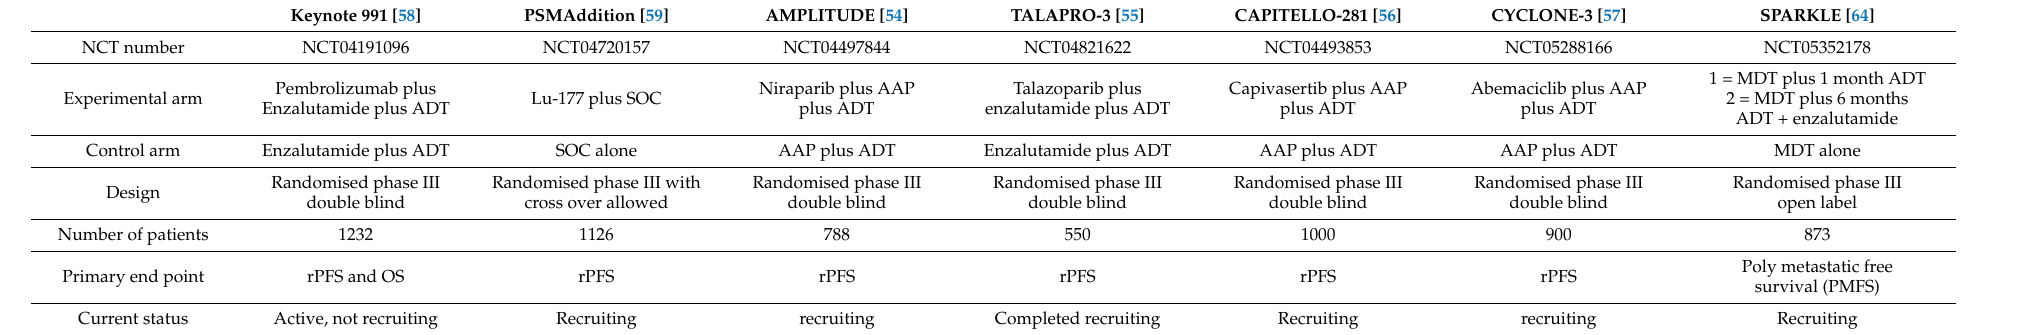
Table 3. Select ongoing trials in